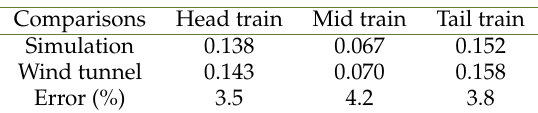
Table 1. Comparison of the C d between simulation and